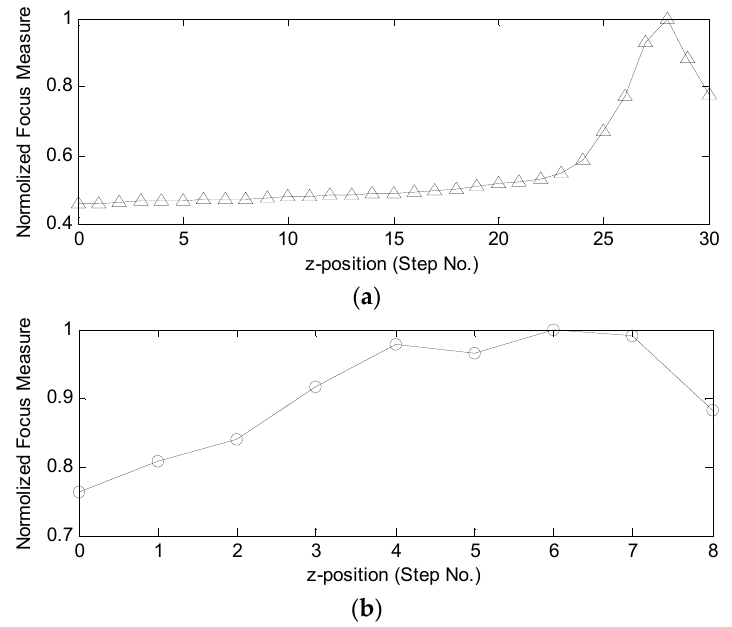
Figure 6. Focusing curves with Brenner gradient function: ( a ) coarse focusing with a step length of 200 μ m; and ( b ) fine focusing with a step length of 50 μ m.